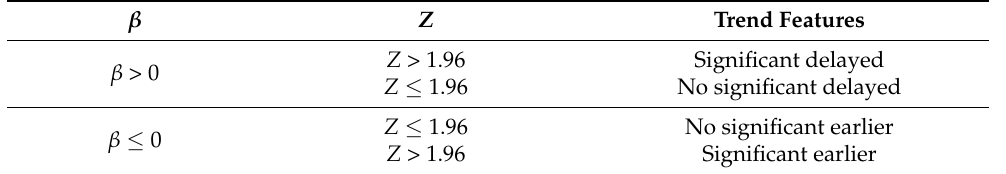
Table 2. Mann–Kendall test trend